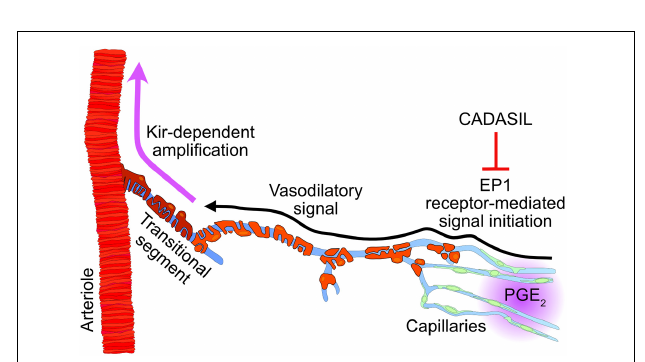
FIGURE 6 | Proposed mechanism involving PGE 2 during functional hyperemia and its inhibition in cerebral small vessel disease (CADASIL). Intracellular increases in Ca 2 + caused by phospholipase C activation during EP1 signaling triggers a propagating vasodilatory signal that is amplified by Kir channel in the transitional segment region. CADASIL, which lowers the pool of phospholipase C substrate PIP 2 , would limit the synthesis of the second messenger IP 3 , resulting in a reduced PGE 2 -evoked upstream dilation during functional hyperemia.